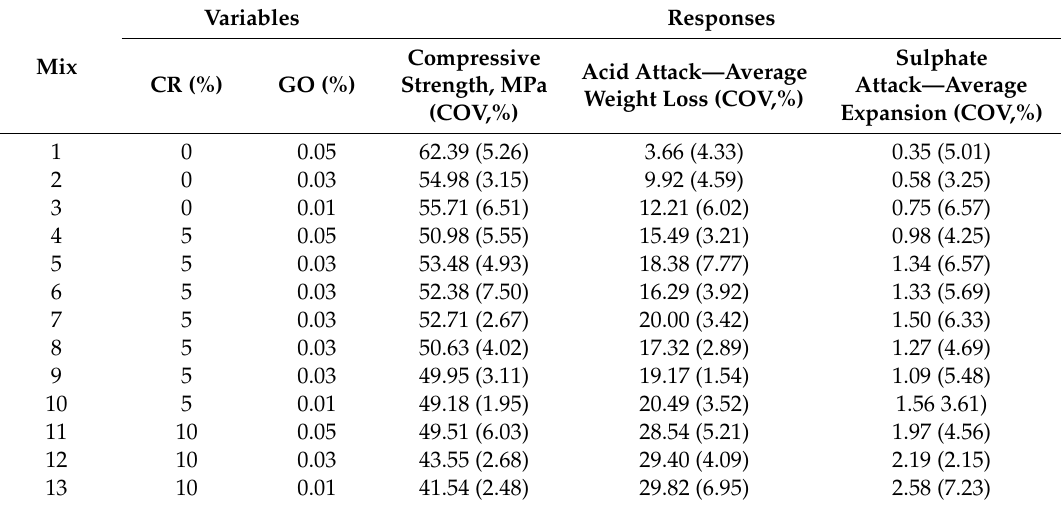
Table 6. Mix combinations and response